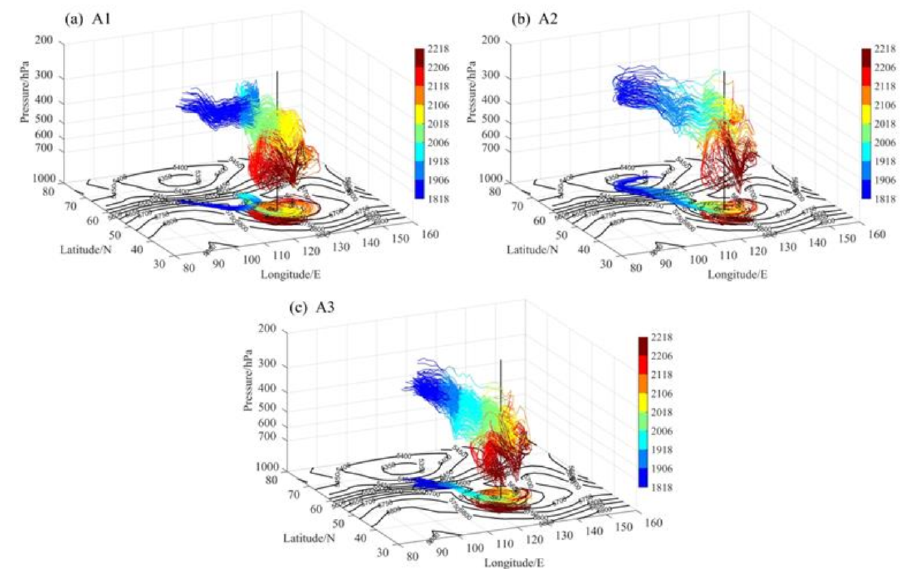
Figure 1. Three-dimensional structure of trajectory clusters corresponding to A1 ( a ), A2 ( b ), and A3 ( c ). Color bars represent the 4-day forward trajectories of the air masses starting at 18:00 UTC on 18 June and ending at 18:00 UTC on 22 June, taken at 12 h intervals. The black contours represent the 500 hPa geopotential height, while the vertical black lines show the central position of the COL at 00:00 on 21 June. The projection of trajectories at the horizontal level are also shown. Table 1. Time series for the average values of longitude, latitude, pressure, PV, and specific humidity.